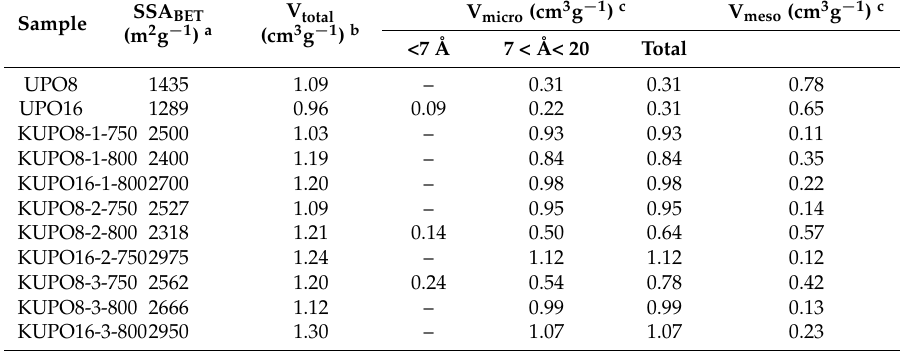
Table 3. Surface area and pore volume for KUPO materials compared to the parent polymers.